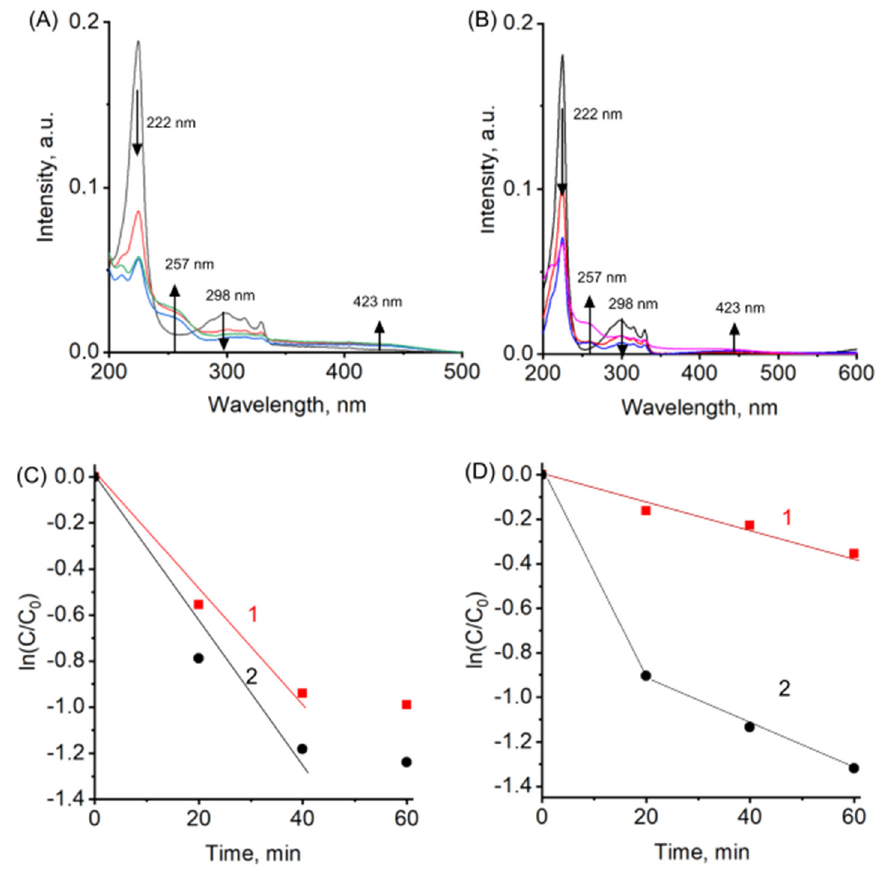
Figure 6. UV-Vis spectra of photodegradation of DHN in aqueous solution assisted by GO/Zn (OAc) 2 /PA-PDI hybrid materials ( A ) and the GO/PA-PDI composite ( B ) at λ > 410 nm, and the corresponding kinetic curves of ( C ) GO/Zn (OAc) 2 /glu-PDI (1) GO/Zn (OAc) 2 /PA-PDI (2) hybrid materials and ( D ) GO/glu-PDI (1) GO/PA-PDI (2) composites. The kinetic curves were calculated from the peak at λ = 222 nm. Arrows indicate the reaction time. The concentration of DHN was 10 − 5 M. The spectral picture of the reaction is given only for the PA-PDI-based materials; for that of glu-PDI, see Figure S8.